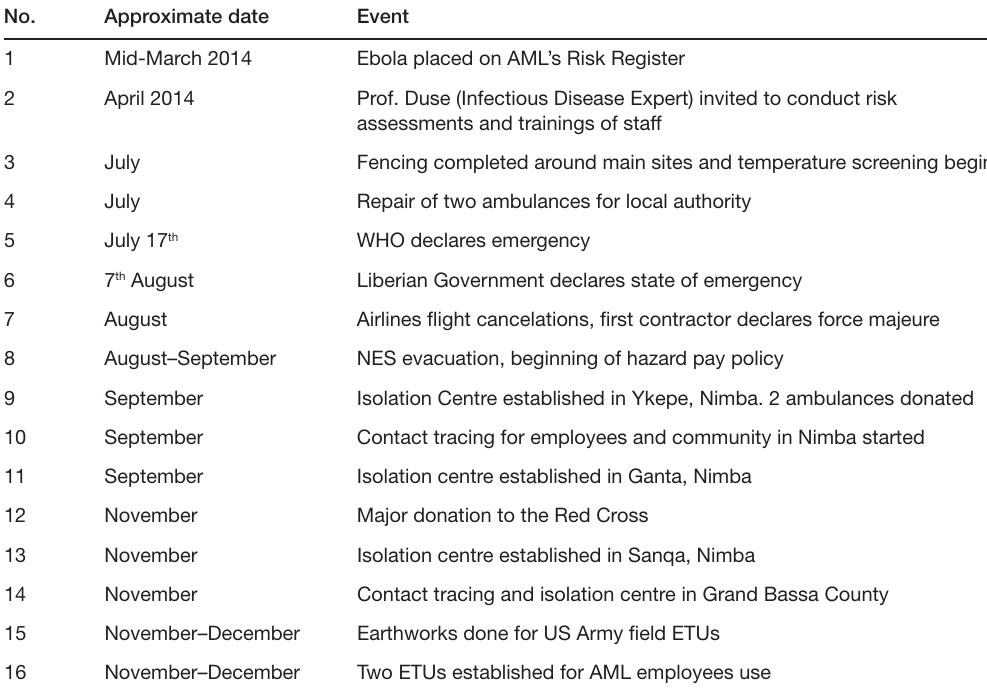
Table 4. Timeline of events and actions taken by the